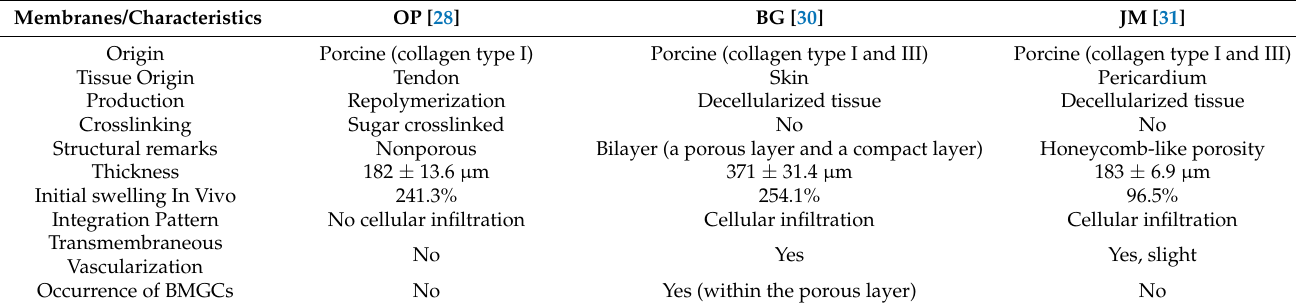
Table 3. Concluding comparison of the investigated barrier membrane, Ossix ® Plus, and the controls, Bio-Gide ® and Jason ®